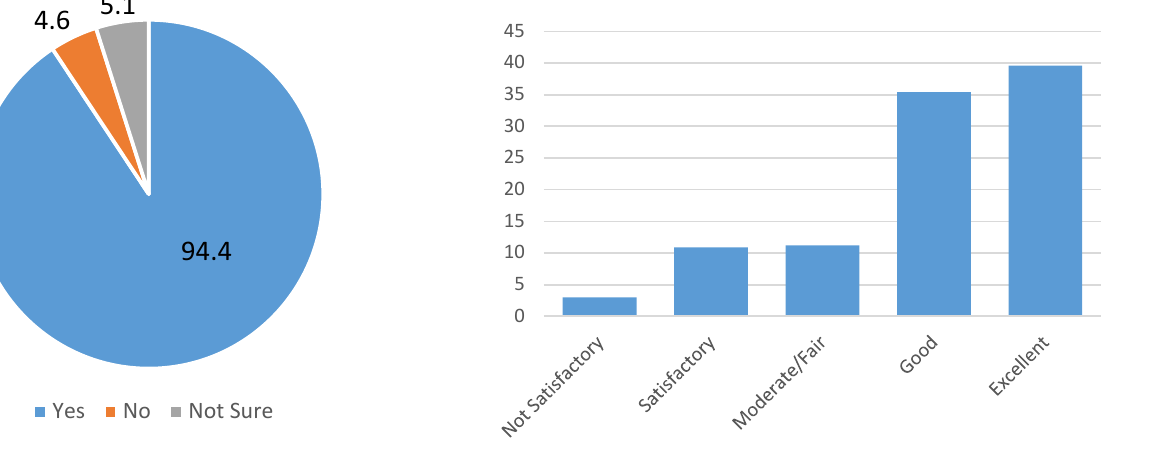
Figure 7. Sharing travel experience with others Figure 8. Previous travel experiences